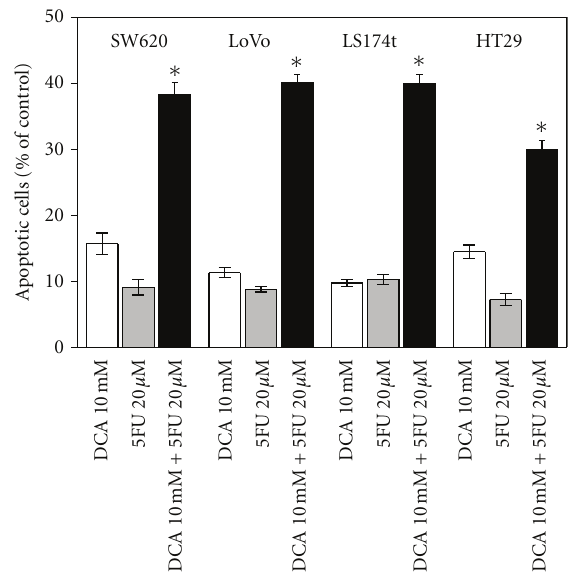
Figure 4: Induction of apoptosis in SW620, LoVo, LS174t, and HT29 cells after 48-hour treatment with 5-fluoruracil (5-FU) and dichloroacetate (DCA) alone or in combination. Each bar represents the mean ± SD ( n = 3); ∗ P < .